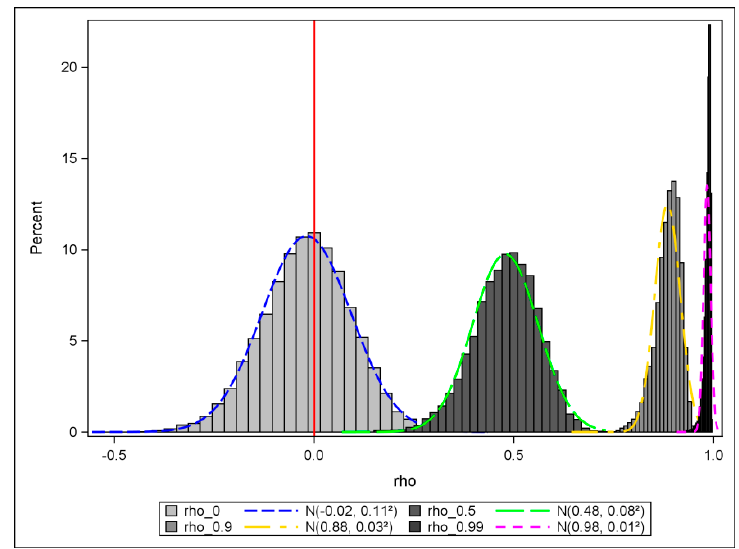
Figure 1. Selected frequency distributions of simultaneous autoregressive (SAR)-estimated 𝜌 .